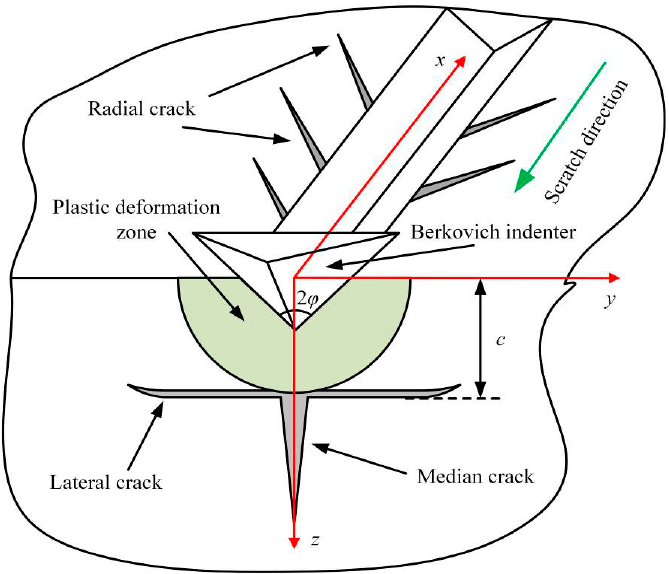
Figure 12. Diagram of the surface/subsurface damage during scratching.